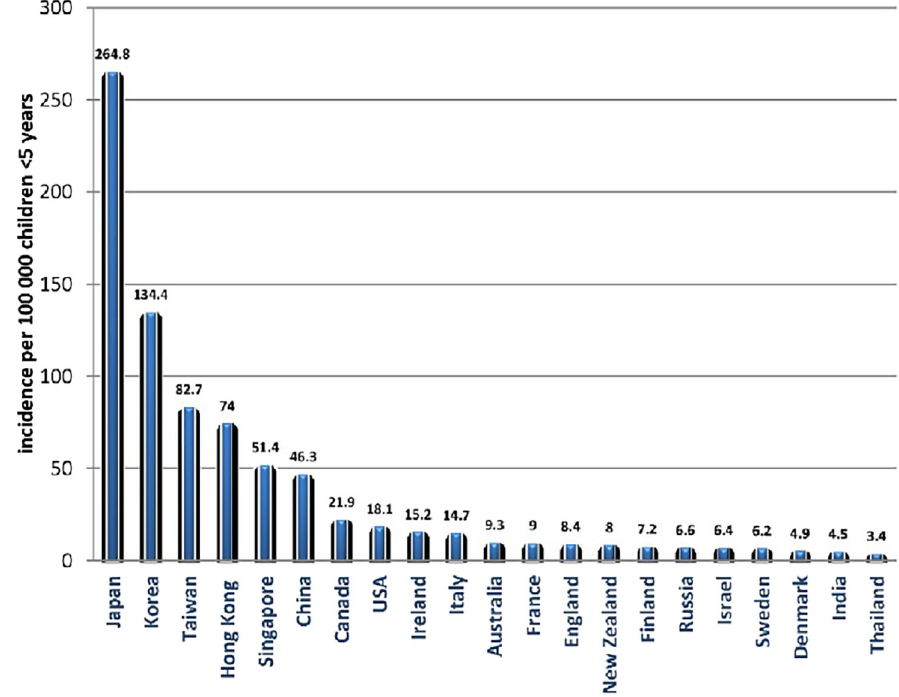
Figure 2. The global incidence of Kawasaki disease per 100,000 children under 5 years old (Figure from Elakabawi et al. , 2020).